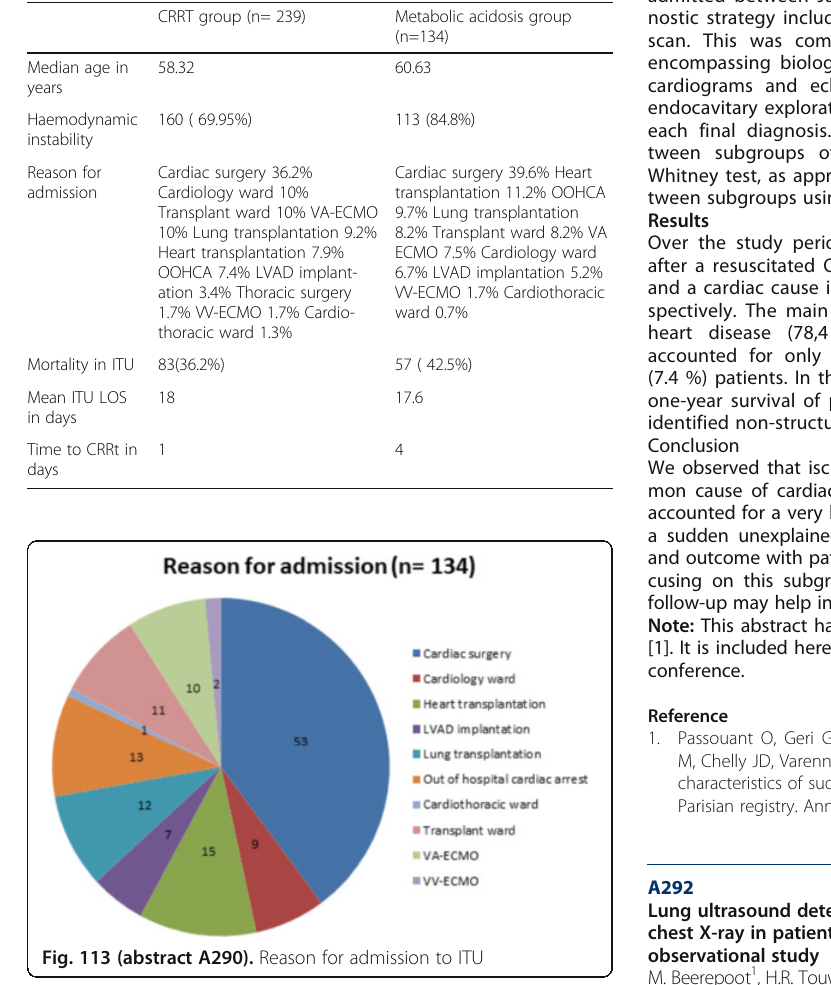
Table 87 (abstract A290). Groups comparison